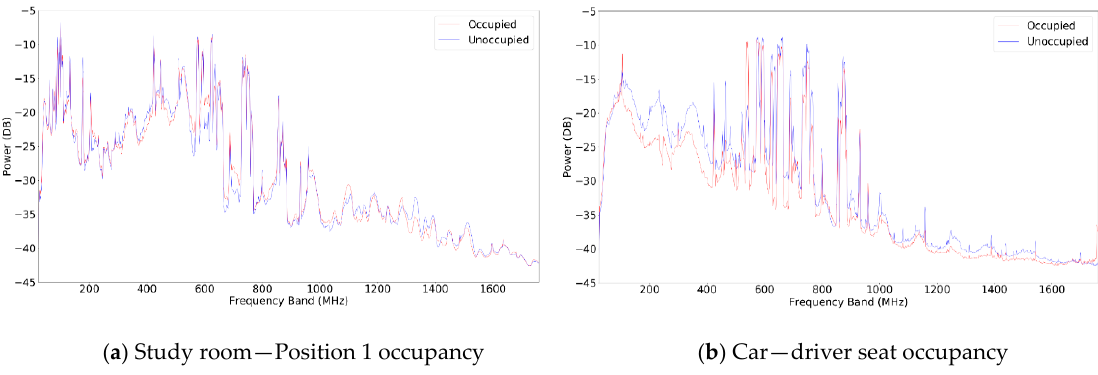
Figure 3. Average power spectrum of occupied vs. unoccupied. ( a ) Study room—Position 1 occupancy. ( b ) Car—driver seat occupancy.